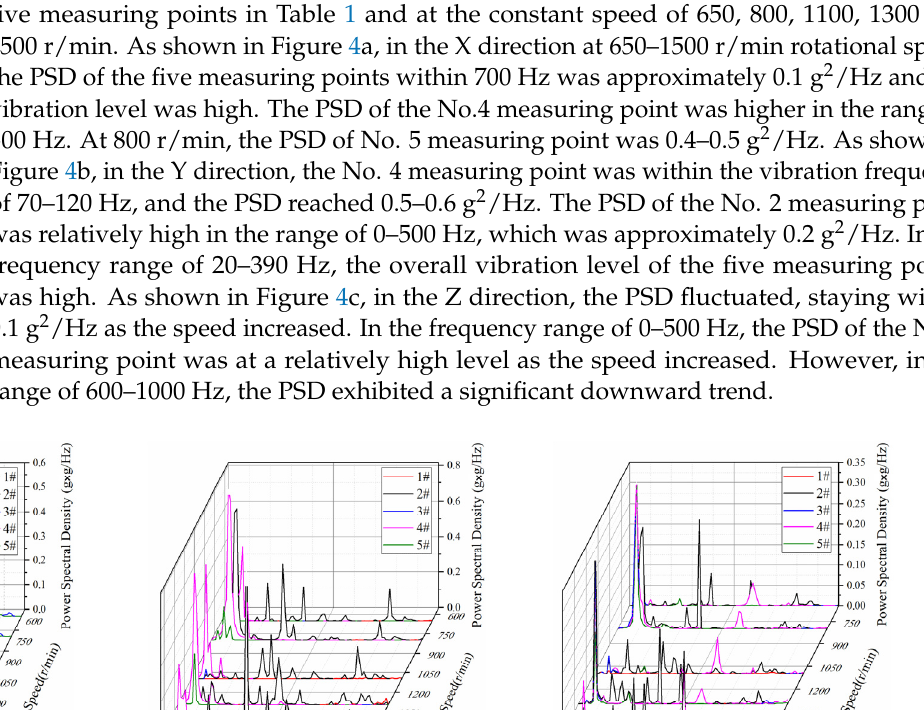
Figure 3. Comparison of the time domain analysis results of the exhaust cylinder vibration,where 1# is the NO.1point in Table 1. And so on.